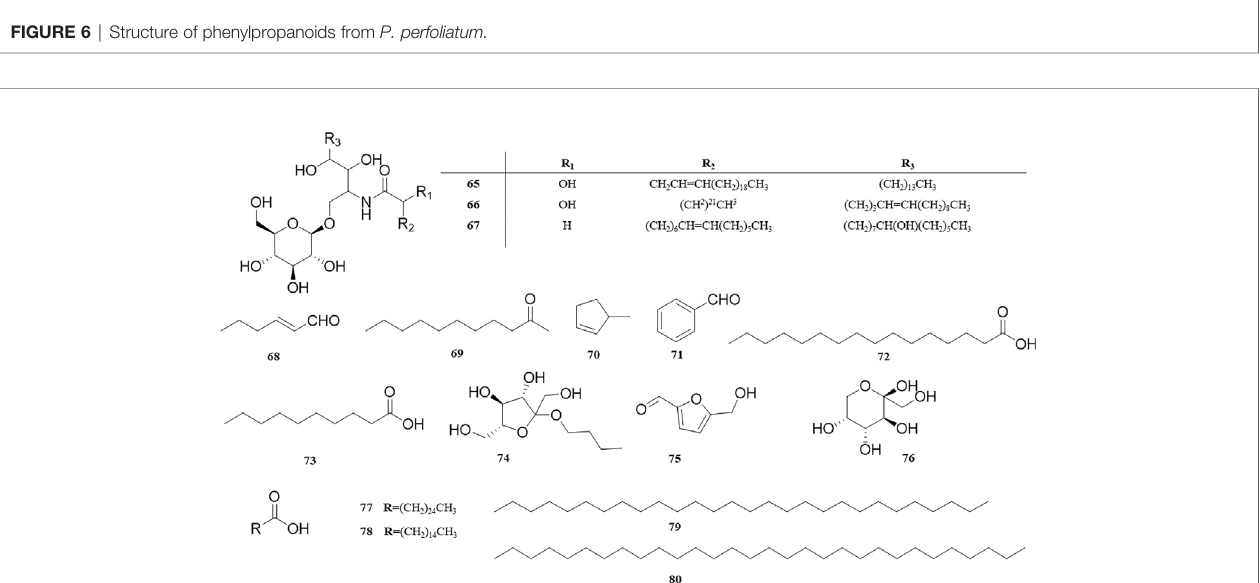
FIGURE 7 | Structure of alkaloids and other compounds from P.